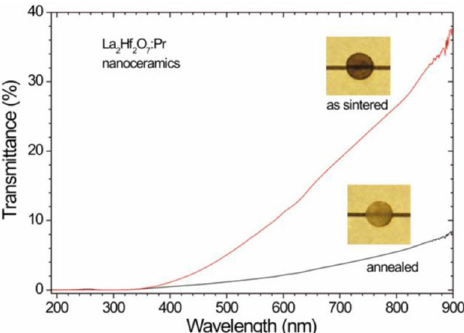
Fig. 11 Transmittance of La 2 Hf 2 O 7 :Pr ceramics before and after annealing (~1 mm thick; inset: their photos). Reproduced with permission from Ref. [42], © John Wiley and Sons 2014.